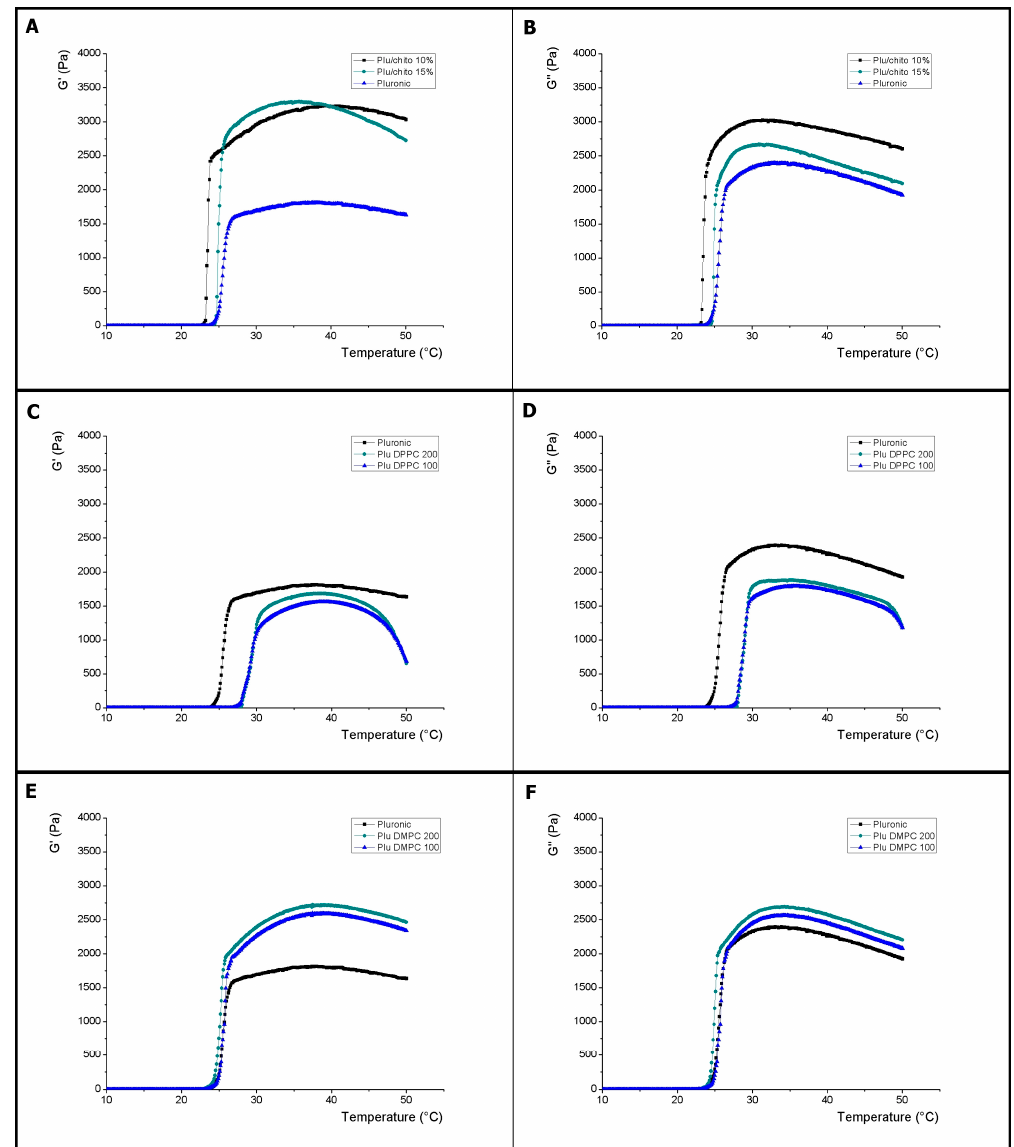
Figure 1. Variation of elastic ( G ′ ) and viscous ( G ′′ ) modules as a function of temperature. ( A , B ) corresponds to the Pluronic F127 control and the effect of incorporation of chitosan (F10% and F15%); ( C , D ) correspond to the effect of incorporation of DPPC-composed Liposomes made by extrusion with 100 and 200 nm membranes (plu 100 and plu 200, respectively) on Pluronic F127; ( E , F ) correspond to the effect of incorporation of DMPC composed Liposomes made by extrusion with 100 and 200 nm membranes (plu 100 and plu 200, respectively) on Pluronic F127.